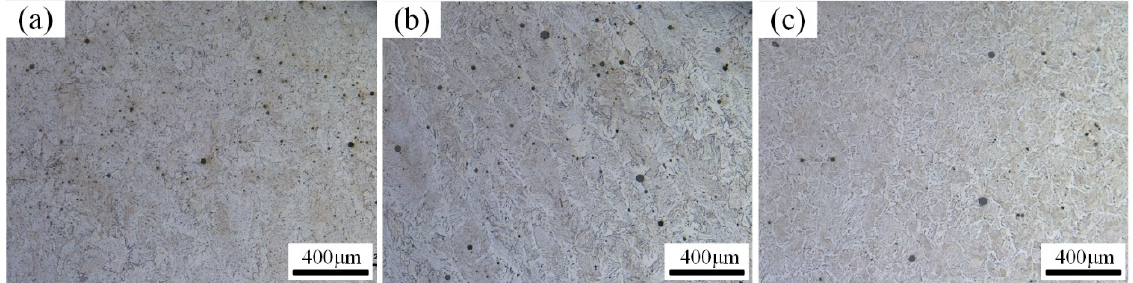
Figure 7. Pores distribution in the welds. ( a ) UWW, ( b ) WG-USAW and ( c )